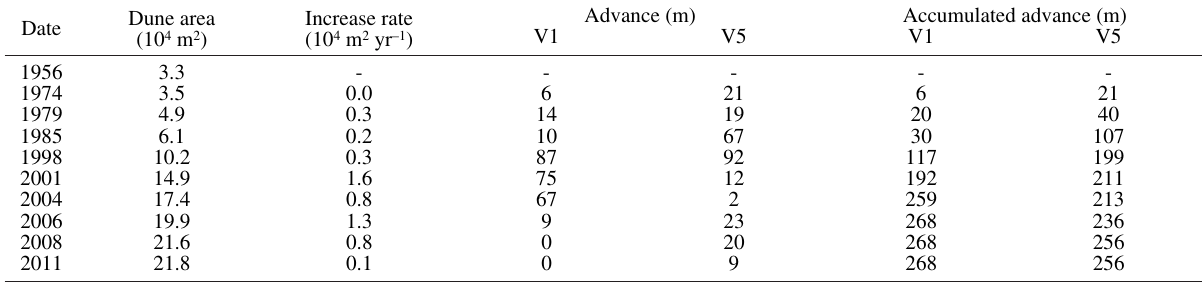
Table 3. – Dune area and advance rates for Valdevaqueros profiles V1 and V5 from 1956 to 2011.